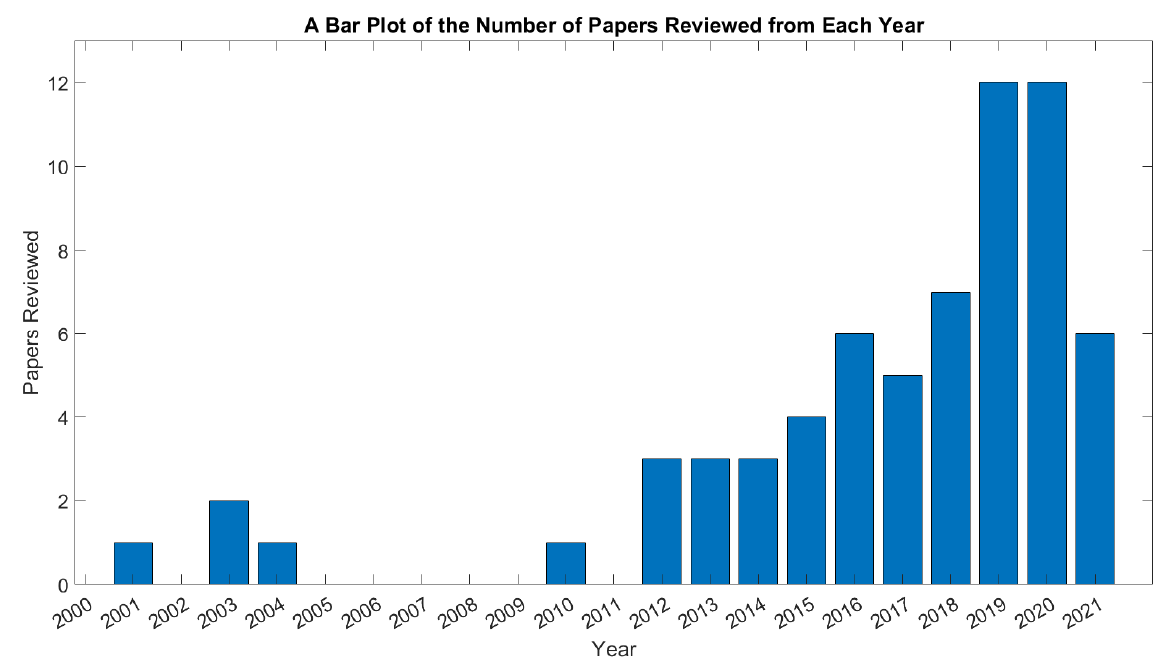
Figure 2. A year-by-year breakdown of the reviewed literature.